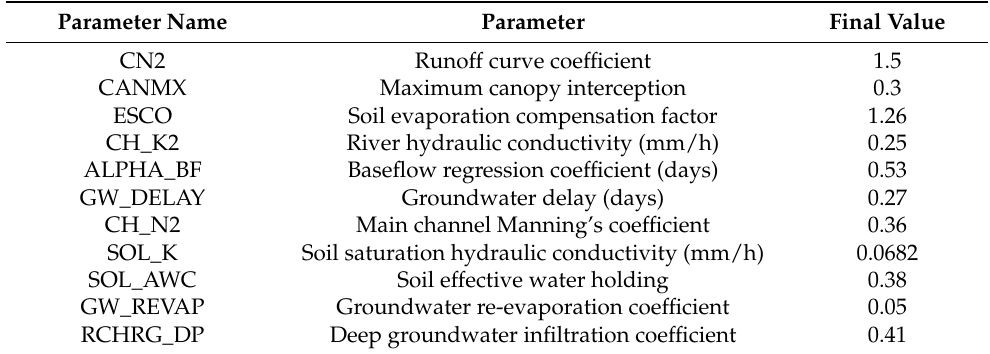
Table 1. Model calibration parameters.